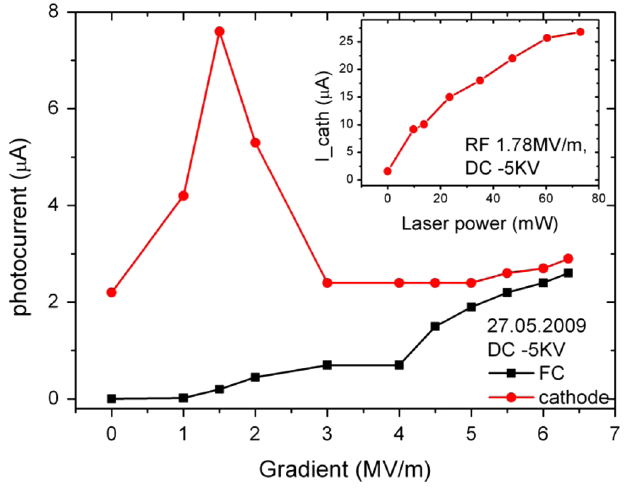
FIG. 9. (Color) Measured photocurrent versus cavity gradient with constant laser power. The current was measured at different positions: Faraday cup current (FC, black squares) and cathode current (red circles). The inset shows the cathode current scan vs laser power at the gradient of 1 : 78 MV = m , where the peak in the cathode emission current